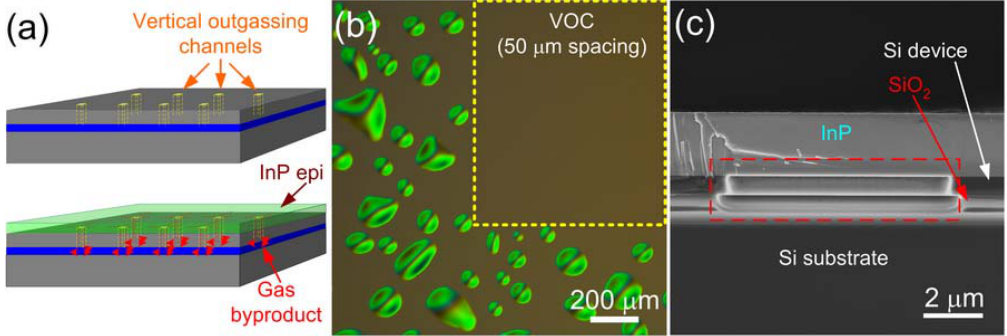
Figure 2. (a) Schematic cartoons of vertical outgassing channels (VOCs) on the SOI substrate before (top) and after (bottom) contacting InP epitaxial layers. (b) Normaski microscopic images of an InP-to-SOI bonded pair after 300 °C anneal for 30 min, showing noticeable contrast between VOC region (yellow dash line box) and non-VOC region. (c) SEM cross-sectional view of VOCs with InP epitaxial layers bonded on top, showing intimate contact with no deformation or delamination. Red dash line box highlights a single